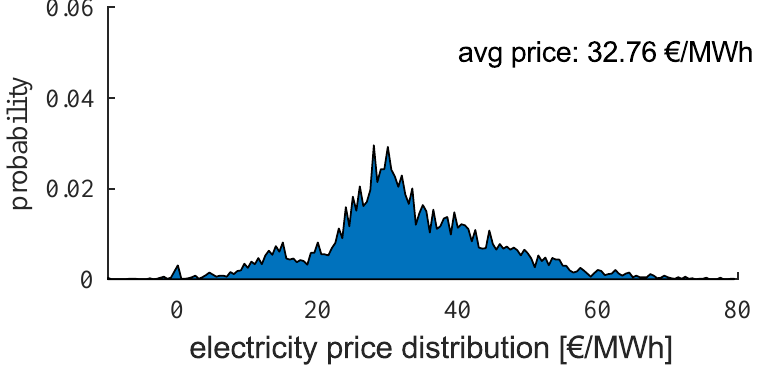
Figure 7. Empirical day-ahead price distributions for Germany in 2014